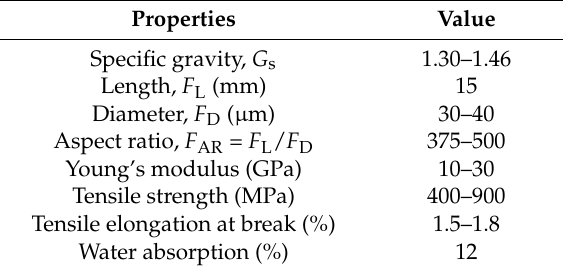
Table 3. Physical and mechanical properties of JF (as supplied by the distributor).